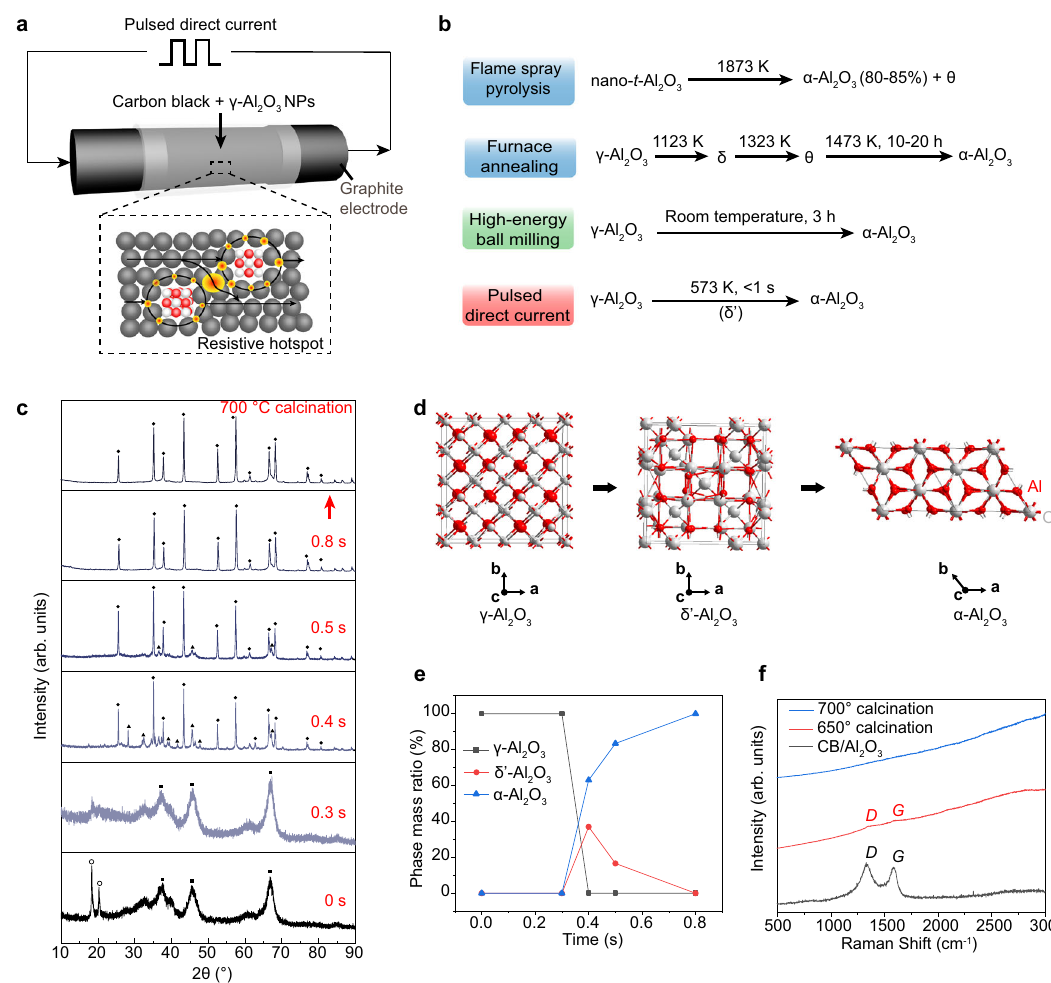
Fig. 1 | Ultrafast phase transformation of alumina by pulsed direct current (PDC)Jouleheating.a SchematicsofthePDCapparatus,andtheresistivehotspots around and at the gaps of the insulative γ -Al 2 O 3 NPs. The black arrows depict the electriccurrentlines. b Representativemethodsforthephasetransformationfrom fl ame spray pyrolysis, ref. 20 furnace annealing, ref. 16 high-energy γ - to α -Al 2 O 3 : ballmilling,ref.13PDC,thiswork. c X-raydiffraction(XRD)patternsof γ -Al 2 O 3 NPs after different PDC durations and the α -Al 2 O 3 NPs product after calcination. The marks: γ -Al 2 O 3 (square), δ ʹ -Al 2 O 3 (triangle), α -Al 2 O 3 (dot), and γ -Al(OH) 3 (circle). The precursor is γ -Al 2 O 3 with ~9wt% γ -Al(OH) 3 phase (gibbsite, crystal